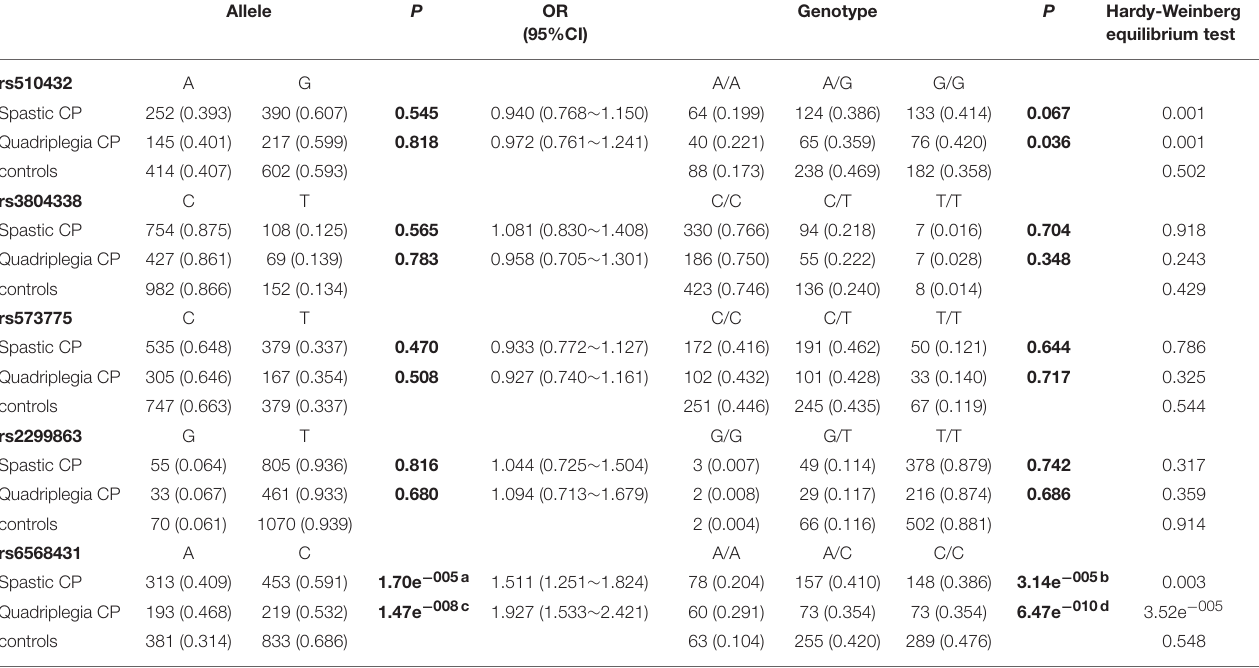
TABLE 4 | Allele and genotype frequencies of ATG5 genetic variants in spastic CP ( n = 468) and quadriplegia CP ( n = 270) and controls ( n = 658). Allele P OR Genotype P Hardy-Weinberg (95%CI) equilibrium